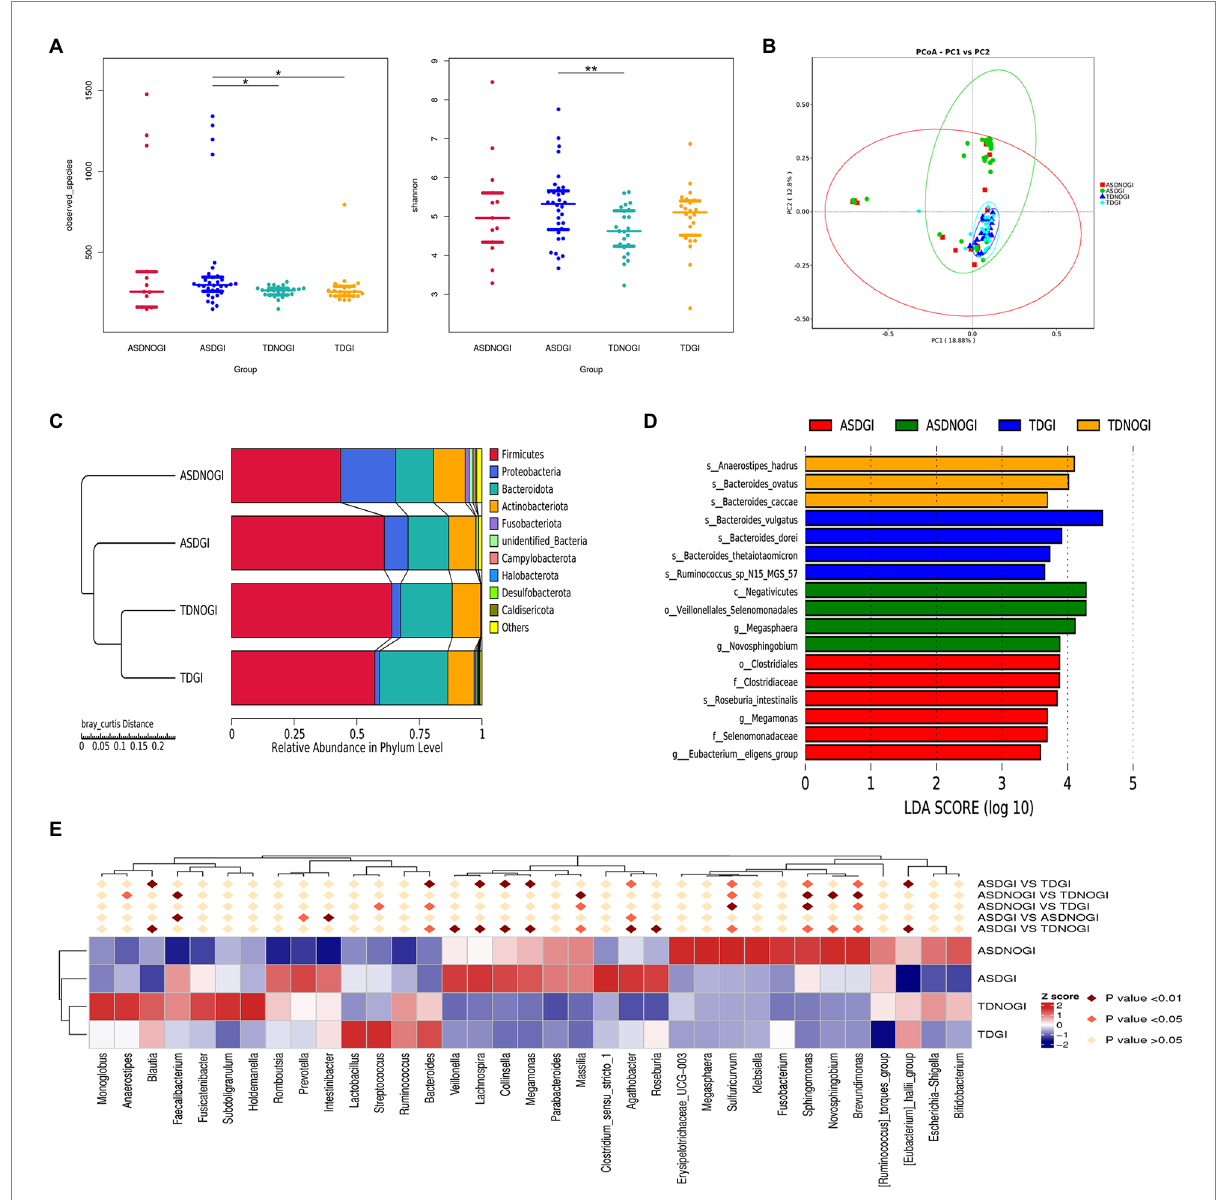
FIGURE 4 The gastrointestinal symptoms affected the microbiome in the ASD and control groups. (A) Evaluated bacterial abundance (observed species) and diversity (beta otu). (B) PCA of bacterial beta diversity based on the Bray–Curtis distance. (C) The major contributing phyla of the gut microbiota according to the Bray–Curtis distance. (D) Distribution histogram of phylum level based on linear discriminant analysis (LDA > 3.5). (E) The heatmap of the top 35 phyla in different